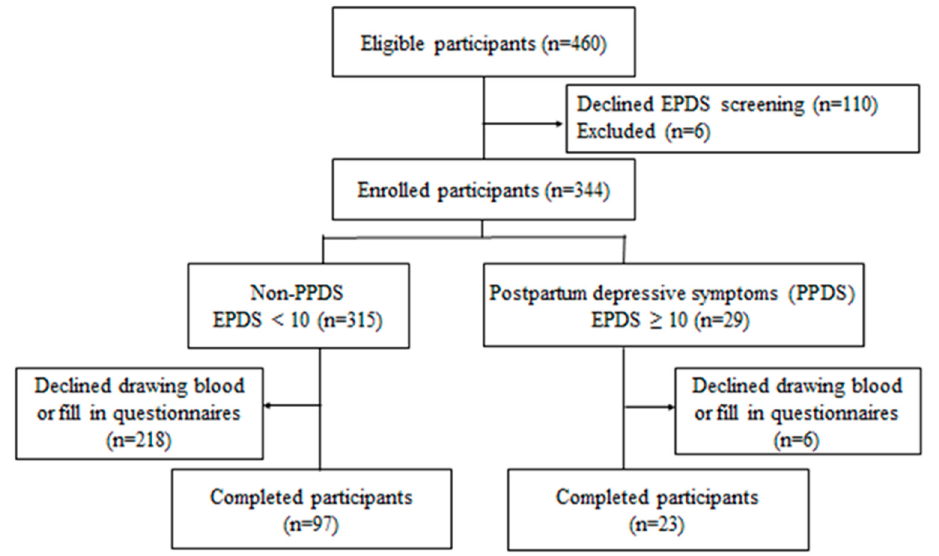
Figure 1. Flowchart of the study.